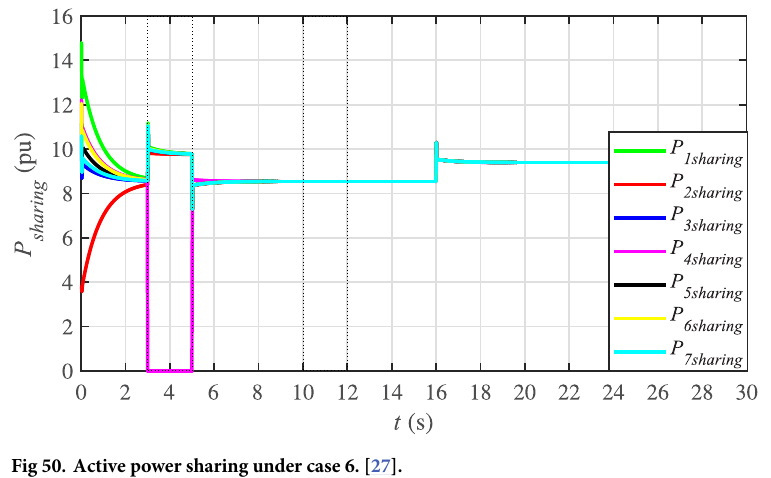
Fig 50. Active power sharing under case 6. [27].